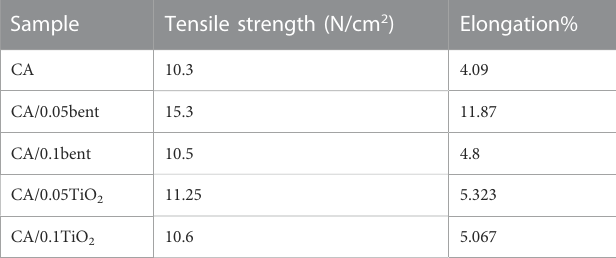
TABLE 1 Tensile strength and elongation% of prepared cellulose acetate nanocomposite membranes. Sample Tensile strength (N/cm 2